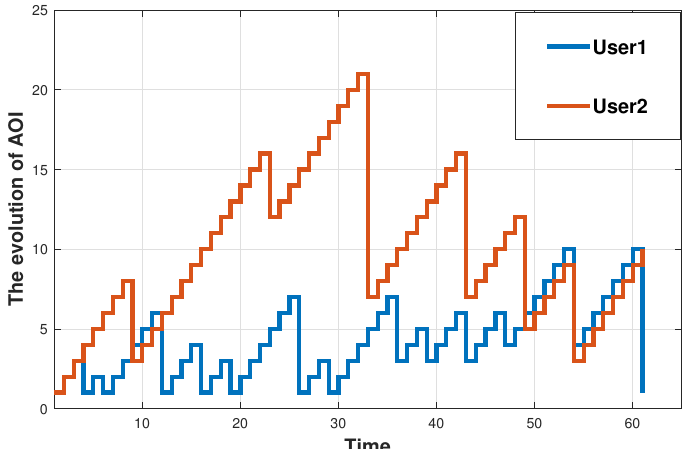
Figure 11. AoI evolution of two mobile